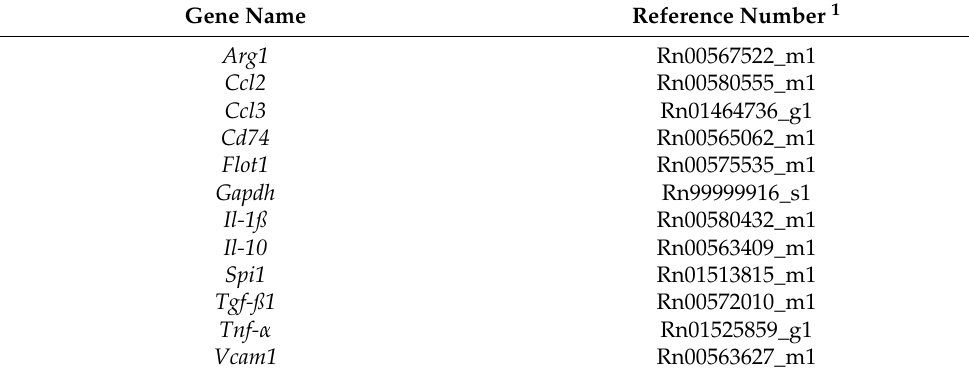
Table 1. List of primers used in this